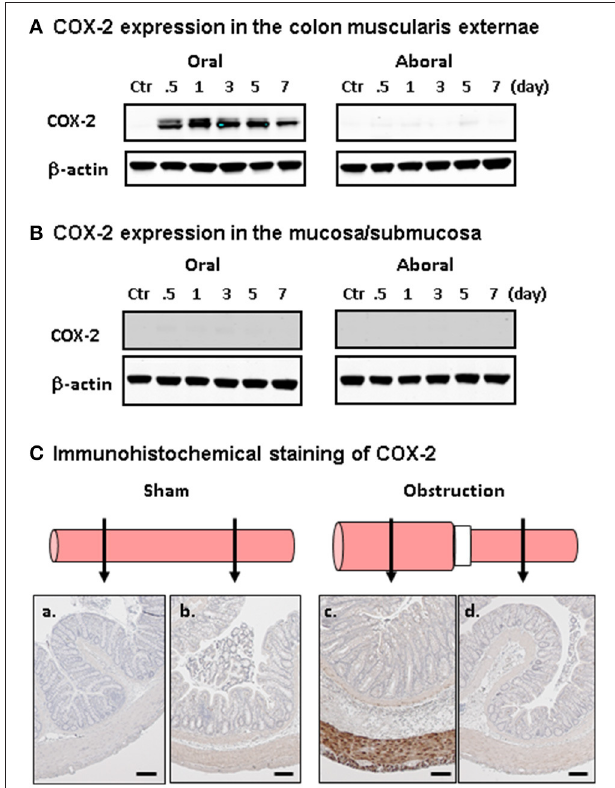
FIGURE 1 | Bowel obstruction induced mechano-transcription of COX-2 selectively in the SMC . (A) Western blot detection of COX-2 in the colonic muscularis externa in the oral (left) and aboral (right) segments. (B) Western blot detection of COX-2 in the mucosa/submucosa in the oral (left) and aboral (right) segments. (C) Immunohistochemical staining of COX-2 expression in the oral (a,c) and aboral (b,d) colon segments in sham control (a,b) and rat with obstruction (c,d) for 3 days. Note that COX-2 (stained in brown) is detected only in SMC in distended oral segment. The results were representative of four independent experiments. Calibration bars represent 50 µ m. Figure is adapted with permission from Shi et al. (2011) (PMCID: